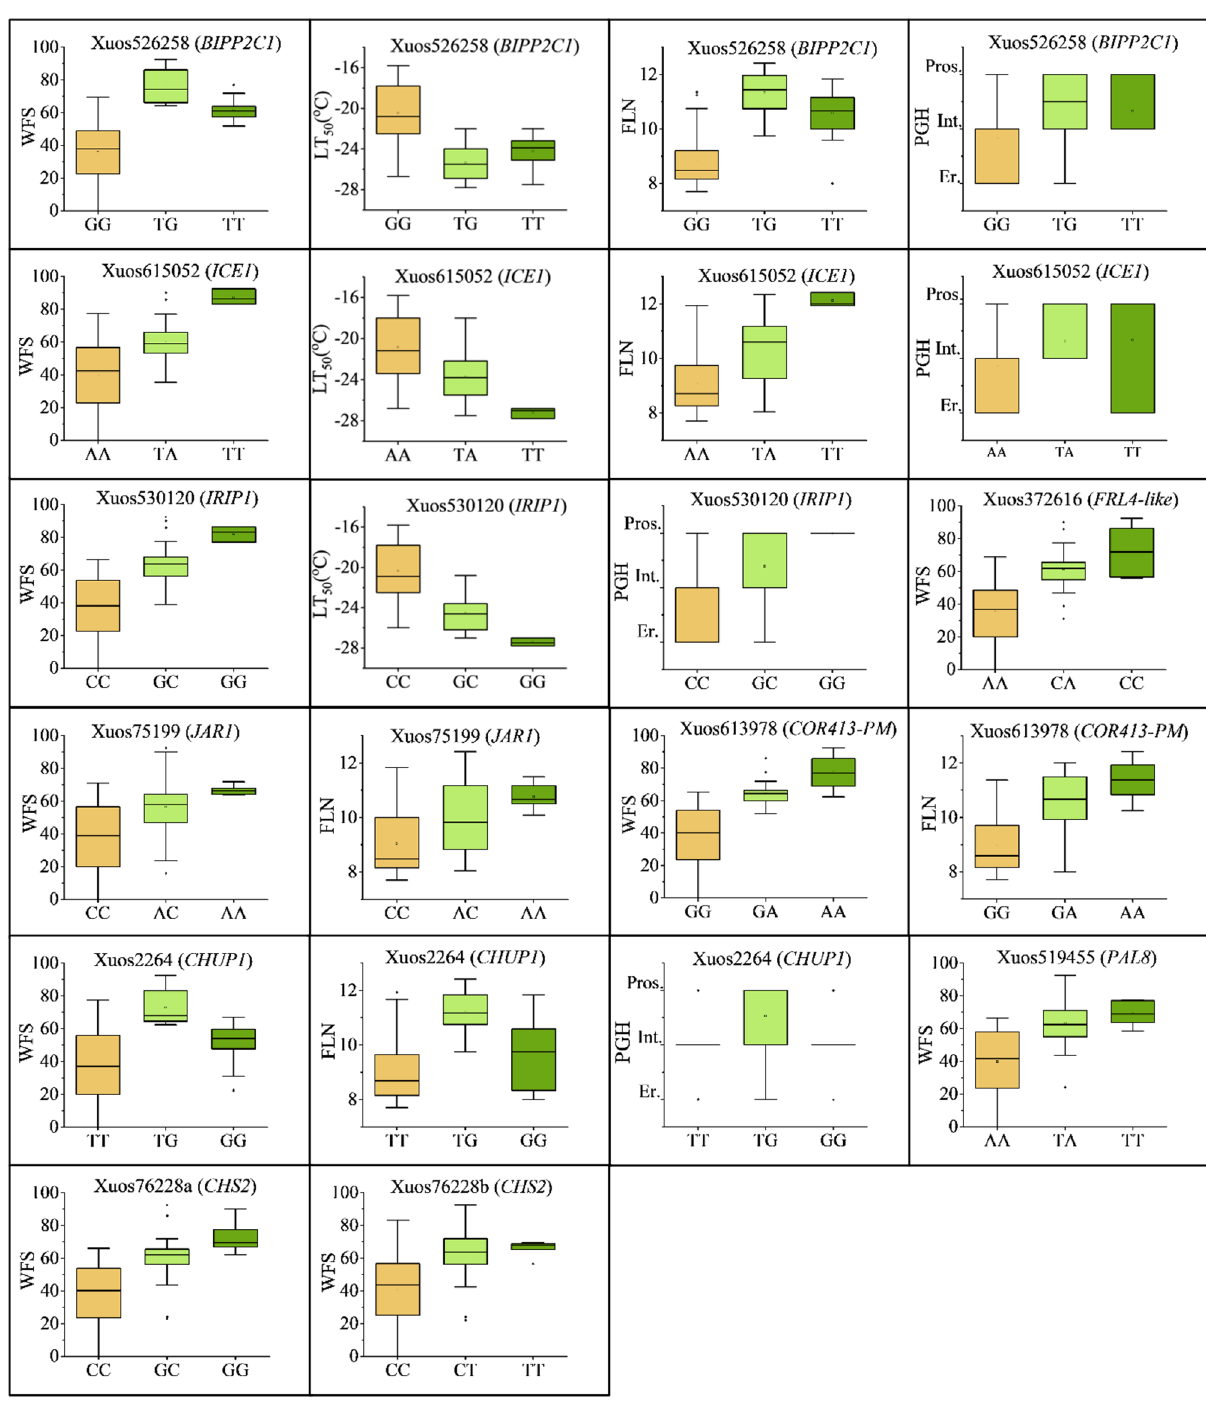
Figure 2. Box-whisker plots showing the allele effects for the most significant ( p < 1.49 e−04) MTAs. The plots show median (horizontal bar), interquartile ranges (boxes), ranges (whiskers), and outliers (dots) for marker allele frequencies among the 96 rye ing to NetPhos 3.1 analysis. Genotypes with low or very low WFS encoded only the A 30 variant for COR413-PM, which was also associated with low FLN (Fig. 2; Table S4). High WFS and FLN values were associated with the T 30 modification for COR413-PM (Fig. 2; Table S4).